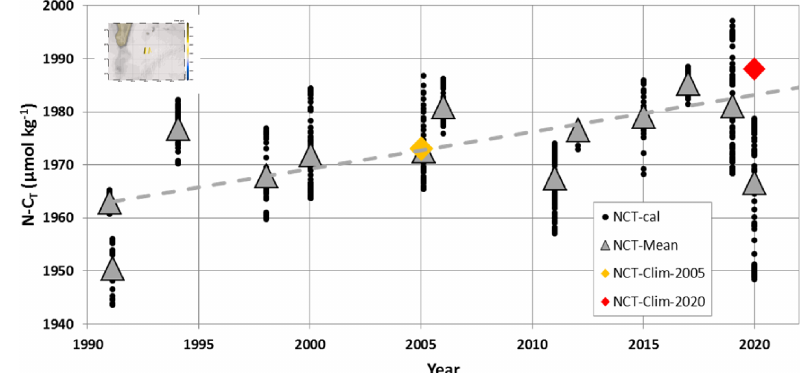
Figure 7. Time series of salinity-normalized C T ( N - C T , black dots) and their monthly mean (grey triangles) at 27–28 ◦ S, 55 ◦ E (in- sert map) calculated with f CO 2 observations (see Fig. 2) and reconstructed A T from salinity (Fig. 6). The figure shows data for the months of January and February (data available from 1991 to 2020 for austral summer). Over the period 1991–2019, the N - C T trend is + 0.70 ( ± 0 . 24)µmolkg − 1 yr − 1 (dashed grey line), reflecting in part the anthropogenic CO 2 uptake. Note the low N - C T in January 2020 in the SEMB compared to previous years with some values around 1950µmolkg − 1 in 2020 as low as N - C T calculated in 1991. The N - C T concentration in the same region derived from the climatology of Takahashi et al. (2014) is also plotted (orange diamond for the reference year of 2005) as well as the climatological value for the year 2020 after correcting for anthropogenic CO 2 (red diamond).